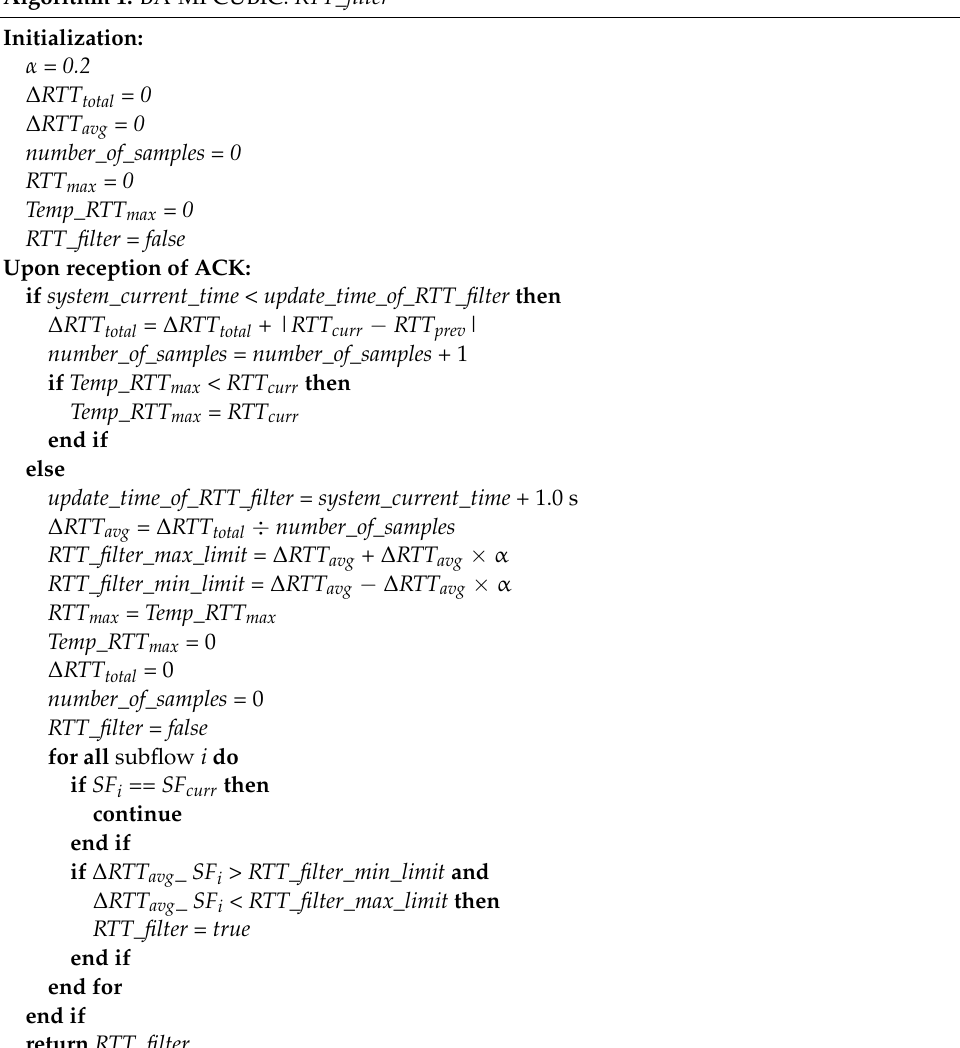
Algorithm 1: BA-MPCUBIC: